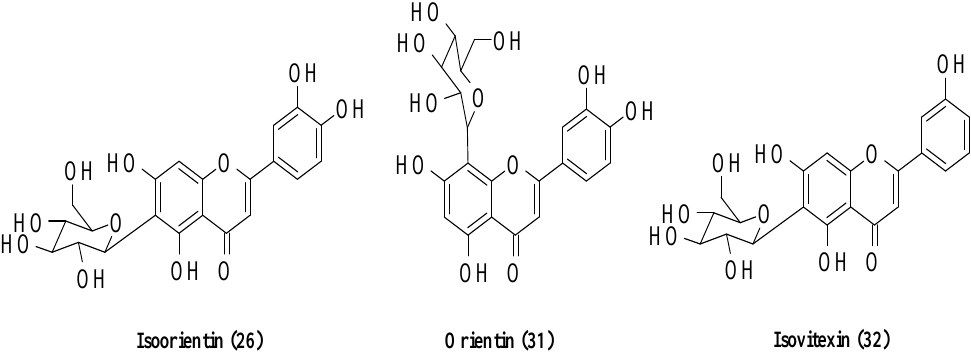
Isoorientin (26) Figure 7. Chemical structures of flavonoids isolated from V. grandifolia [33]. L ó pez-Posadas et al. studied 14 flavonoids’ anti-inflammatory effects on rat splenocytes and carried out their structure–activity relationship [34]. Five different in vitro assays, viz., iNOS inhibition, COX-2 inhibition, the inhibition of cytokine secretion, antiproliferative activity on splenocytes, and the reduction in splenocytes’ viability were conducted to understand the anti-inflammatory effect of these flavonoids. Firstly, for iNOS inhibition, apigenin ( 17c ), luteolin ( 5 ), and quercetin ( 1 ) portrayed complete inhibition; meanwhile, diosmetin ( 17f ) and chrysin ( 17a ) showed weak inhibition. On the other hand, hesperidin ( 19 ), kaempferol ( 6 ), genistein ( 3 ), and daidzein ( 33 ) were reported to be completely inactive against iNOS. For COX-2 inhibition, only 17c and 17f exerted inhibition. The authors discussed the structural requirements needed for both iNOS and COX-2 inhibition. It was highlighted that the presence of hydroxyl groups at the C2 (cid:48) and C4 (cid:48) of the B-ring may influence both activities. In contrast, methoxy and hydroxyl groups at C3 can reduce the iNOS inhibition. Secondly, for the inhibition of cytokine production such as TNF- α , IFN- γ